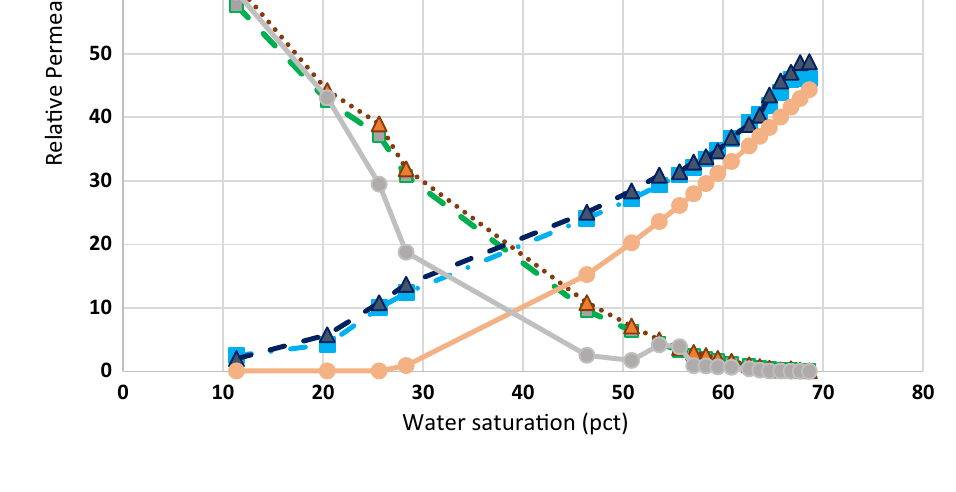
Fig. 13 Sensitivity analysis of individual variables used for building the wetting phase deep learning relative permeability